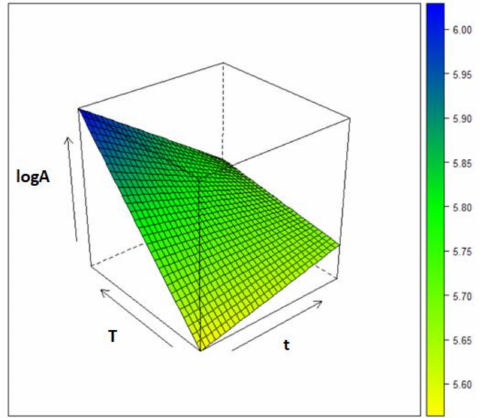
Figure 1. Response Surface associated to the experimental range investigated by the DoE. 2.2. Volatile Profile by of Bell Pepper Spices by HS-SPME/GC-MS The bell pepper spices coming from Altino (Altino 1, 2, and 3), Senise, and a commer- cial paprika have been analyzed by HS-SPME/GC-MS under the optimized experimental conditions. The 59 volatile compounds identified in the GC/MS chromatograms along with the retention time (RT) and the mean relative (%) area in the analyzed samples are reported in Table 2. Table 2. Volatile profiles of bell pepper spices: peak number; observed retention time (RT (min)), assigned chemical structure and mean relative (%) peak area in the GC/MS chromatograms with related standard deviation for each variety: Altino bell pepper (from three different manufactures: 1, 2, and 3), Senise bell pepper, and commercial paprika. Peak n